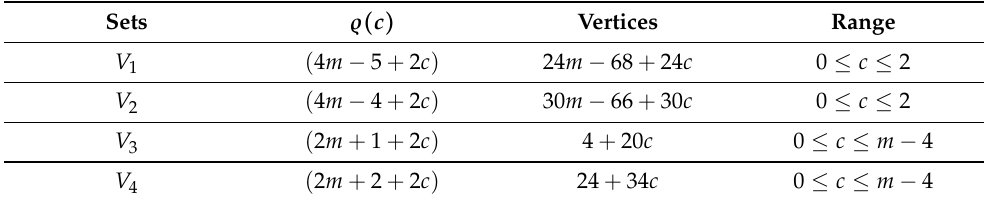
Table 1. Vertex Partition of POH ( m ) with respect to